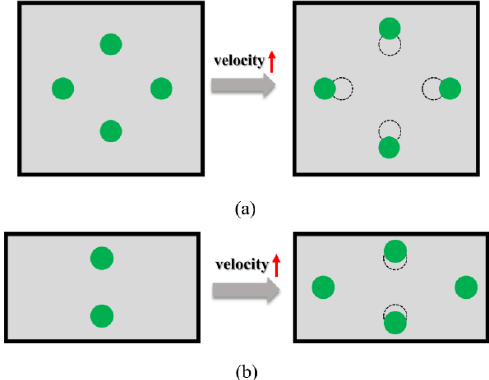
Figure 3. Distribution of equilibrium positions with an increase in velocity in different cross-sections: ( a ) square channel and ( b ) rectangular channel. ( a ) square channel and ( b ) rectangular